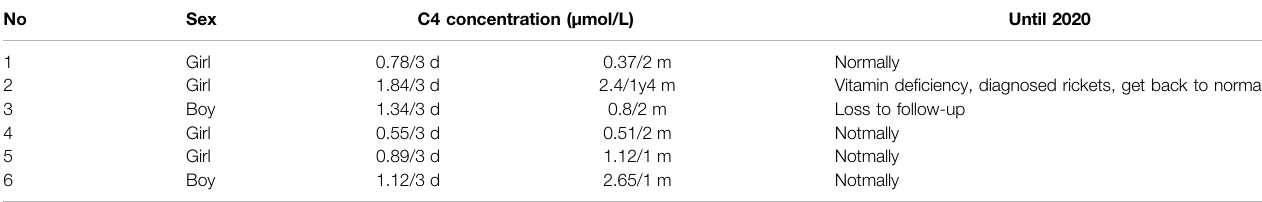
TABLE 3 | Follow-up status of six patients who refused NGS